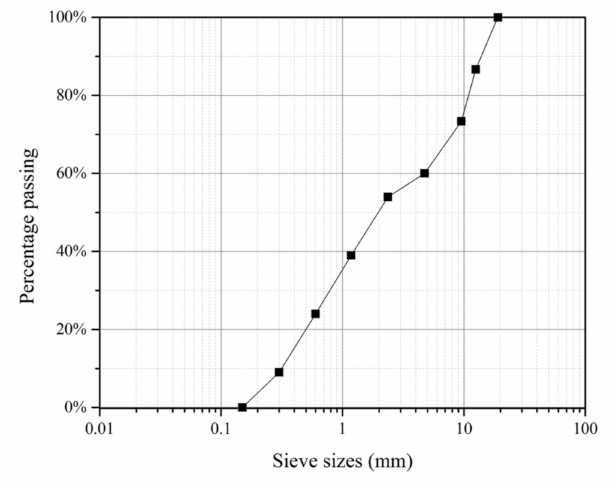
Figure 1. Grading curve of the reactive